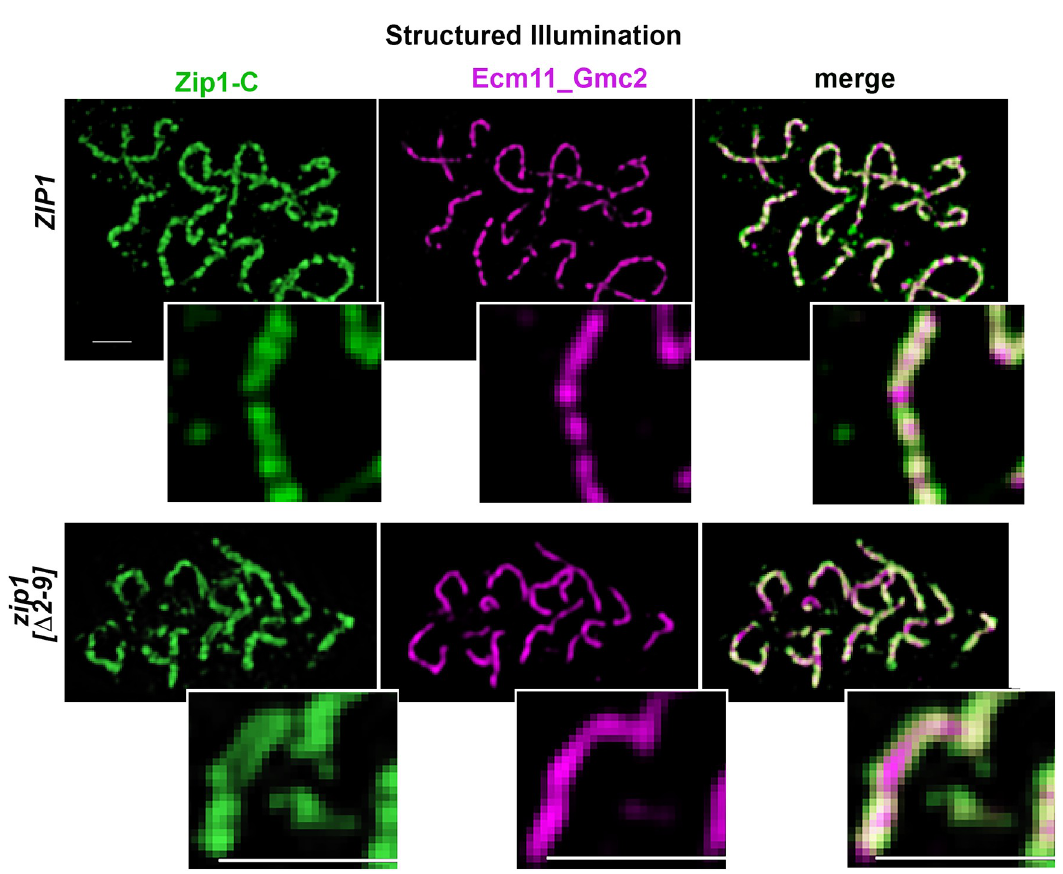
Fig 3. Zip1[ Δ 2–9] assembles with proper orientation within SCs. Structured illumination was used to probe the organization Zip1 and Ecm11 within linear assemblies in wild type (K1268; top panels) and zip1[ Δ 2–9] (AM4064; bottom panels) strains. Antibodies against the C terminal 264 residues of the Zip1 protein (green) were applied in conjunction with antibodies against a mixture of Ecm11 and Gmc2 partial proteins (magenta; see Methods for antibody information). In surface-spread meiotic nuclei containing wild-type SC (top panels), C terminal Zip1 antibody label often displays a wide ribbon in which parallel tracts are sometimes visible with the resolution power of structured illumination (~120 nm) [13]. Such parallel tracts of Zip1 (see zoomed insets) flank a central narrow band of Ecm11-Gmc2 protein, and reflect Zip1’s orientation within the mature SC, where Zip1’s C termini interface with lengthwise-aligned homologous chromosome axes and Zip1’s N termini orient closer to the SC central element (comprised of Ecm11 and Gmc2). DNA is labeled by DAPI in the experiment but not shown in the figure. Bottom panels show a representative spread where wild-type Zip1 organization is apparent within the SCs built by the Zip1[ Δ 2–9] protein. Scale bar, 1 μ